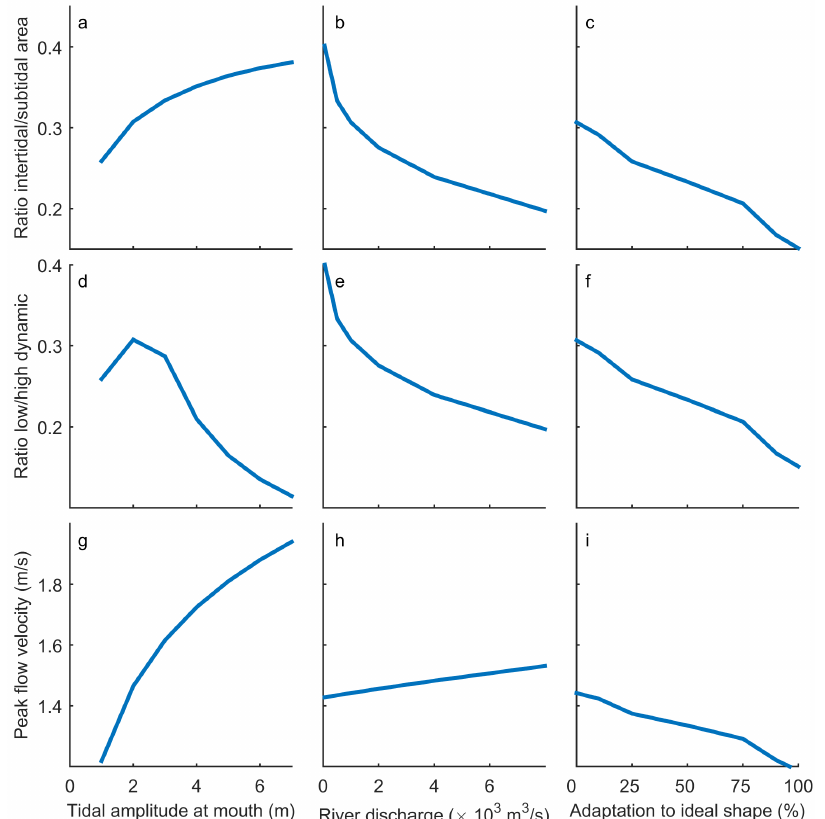
Figure 12. Sensitivity of tool output for the Western Scheldt to input tidal amplitude, river discharge and width profile. The ratio between intertidal and subtidal area increases with tidal amplitude ( a ) and decreases with river discharge and adaptation to ideal shape ( b , c ). The ratio between low dynamic (velocity < 0.8 ms − 1 ) intertidal area and high dynamic area has an optimum curve for tidal amplitude ( d ) and decreases with river discharge and adaptation to ideal shape ( e , f ). Peak flow velocity at the mouth of the estuary increases with tidal amplitude and river discharge ( g , h ) and decreases with adaptation to ideal shape ( i